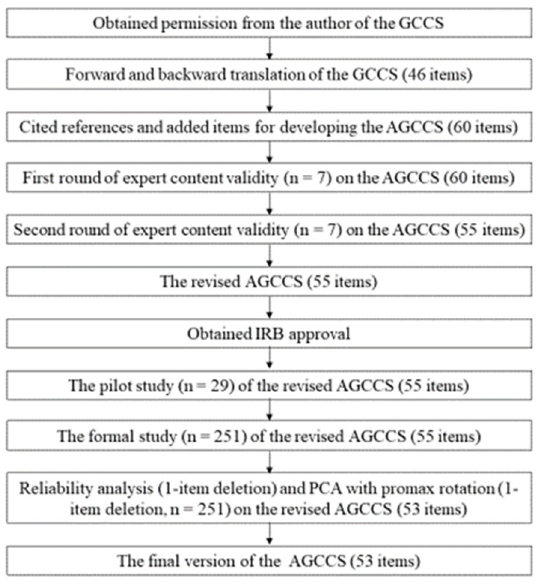
Figure 1. Study procedure.